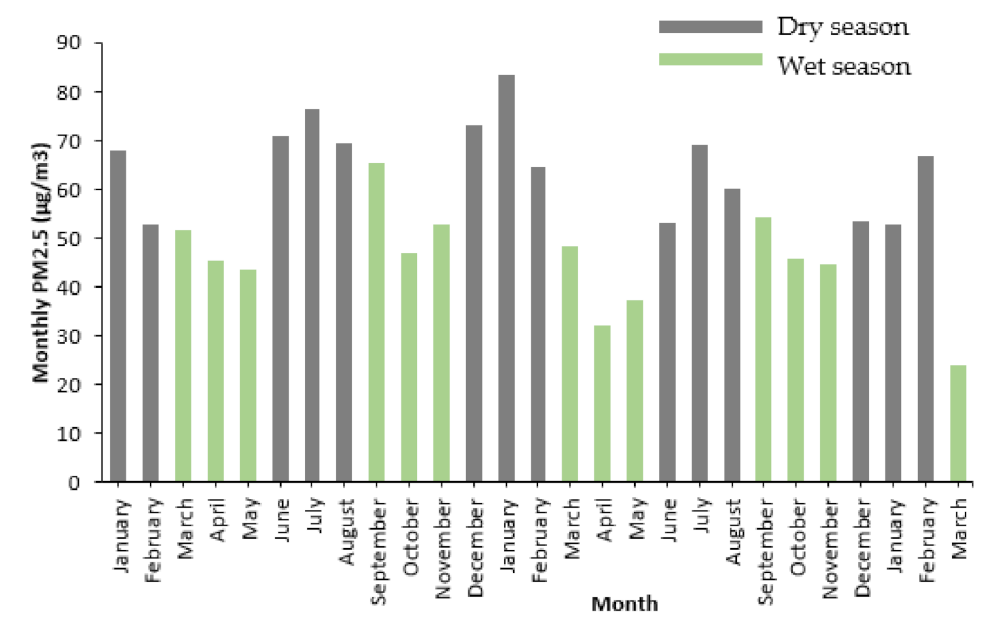
Figure 3. Averaged monthly ground PM 2.5 concentrations for the study period (January 2019 to March